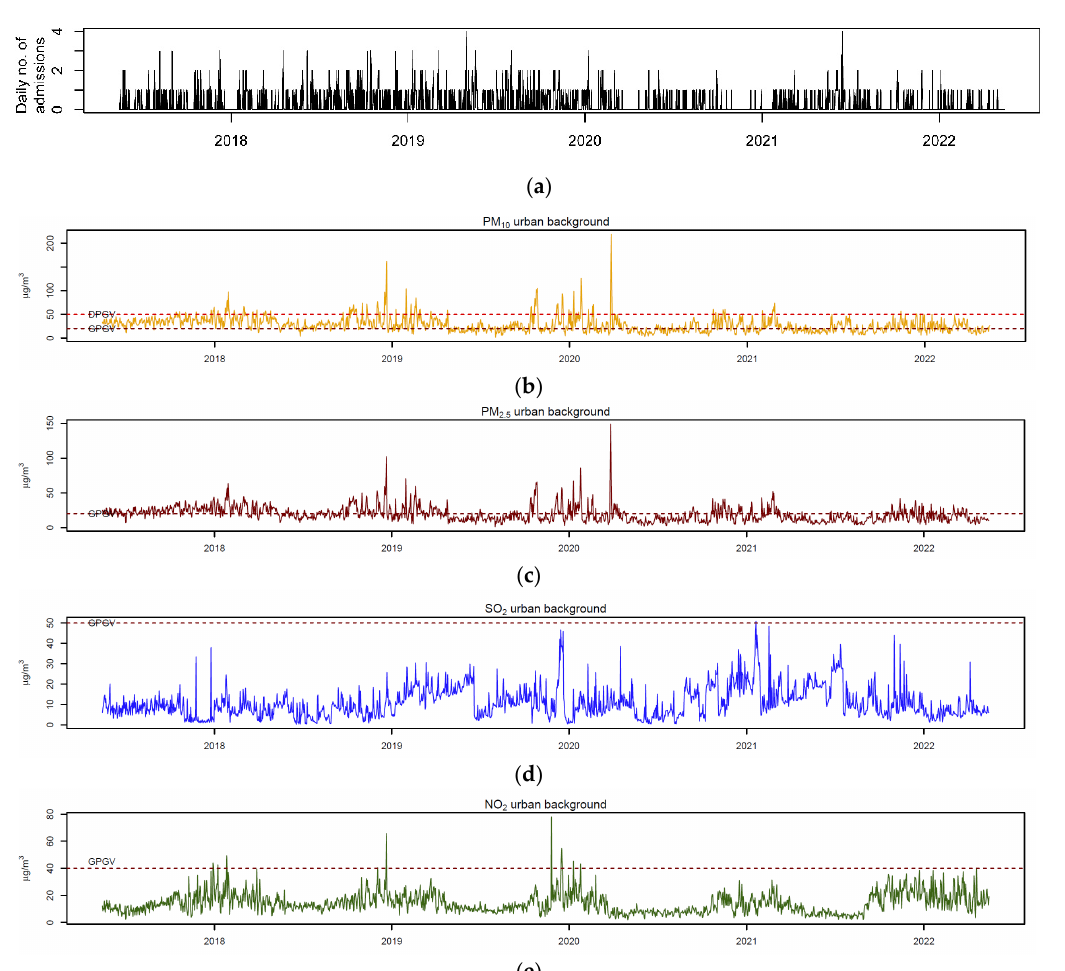
Figure 3. Time-series: ( a ) daily number of AECOPD hospital admissions—vertical axis refers to daily number of AECOPD admissions, horizontal axis to time; ( b ) average daily PM 10 concentrations; ( c ) average daily PM 2.5 concentrations; ( d ) average daily SO 2 concentrations; ( e ) average daily NO 2 concentrations. For air pollutants, the dashed line indicates the daily (red) and annual (dark red) recommended values according to the Directive 2008/50/EC of the European Parliament and of the Council.